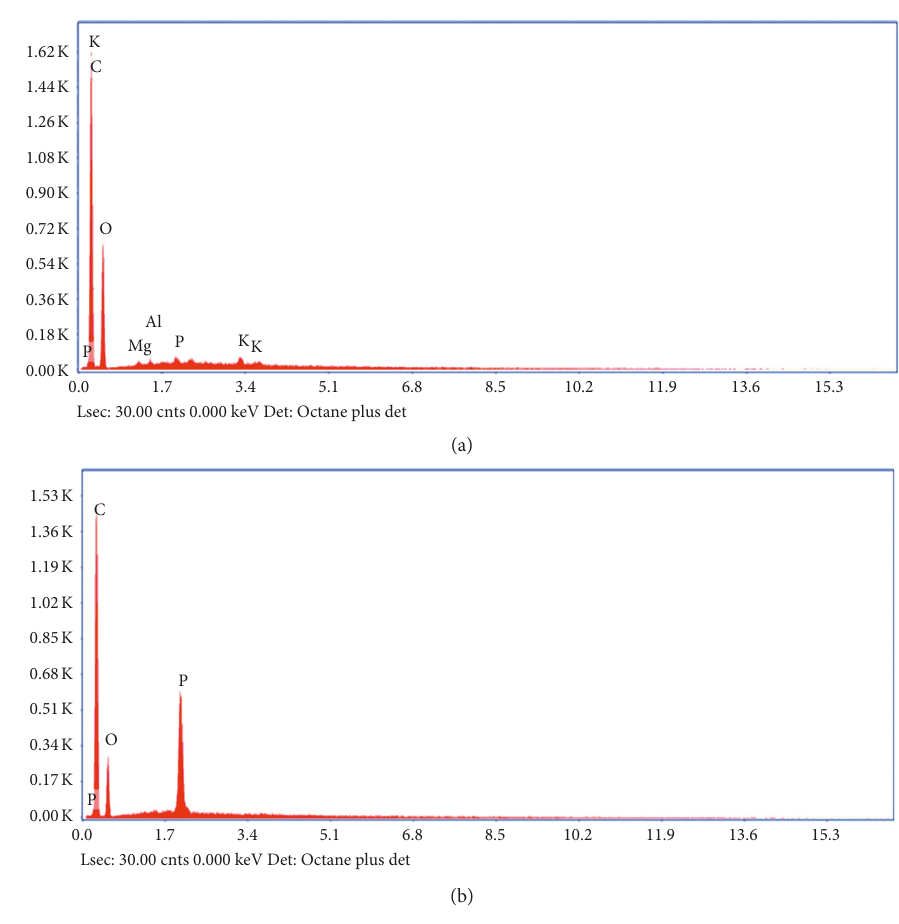
Figure 3: EDX of (a) raw prickly pear seed cake and (b) optimal activated carbon.